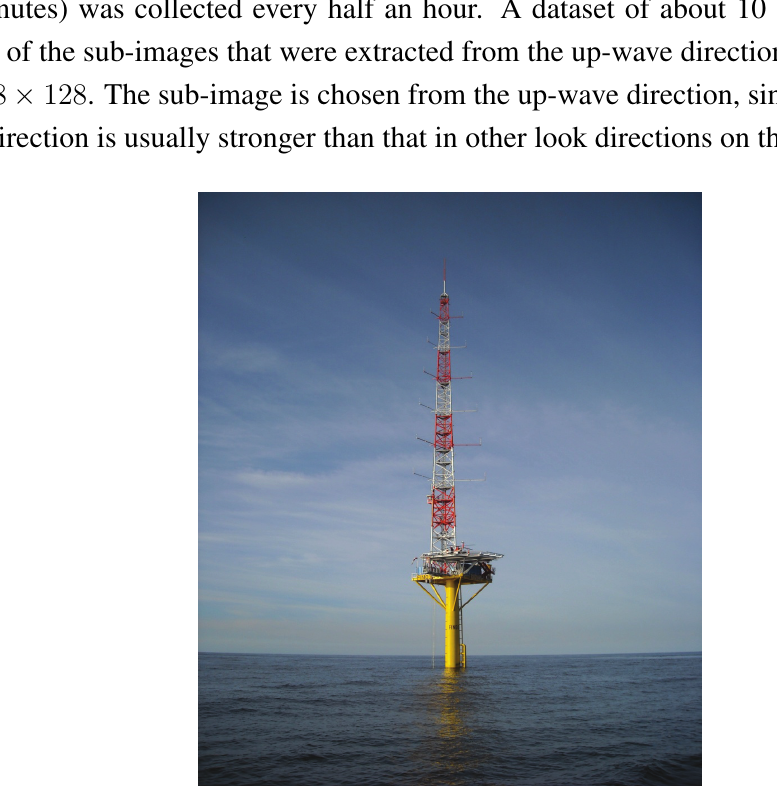
Figure 5. The FINO3 platform on which the radar is